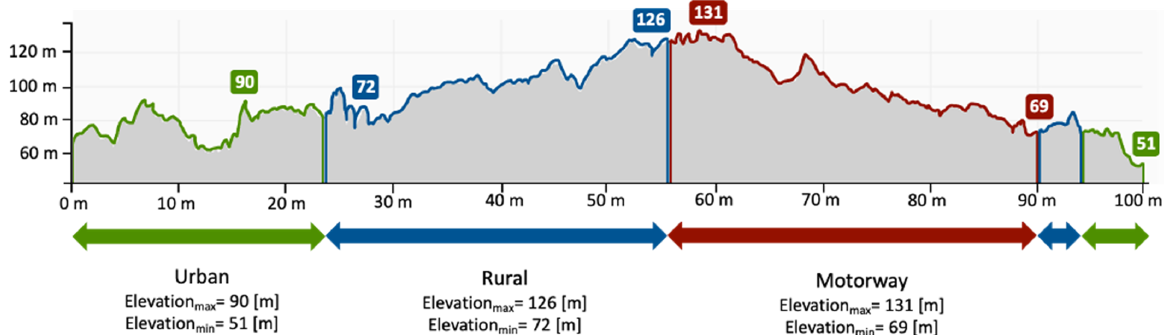
Figure 13. The elevation pattern throughout the route.